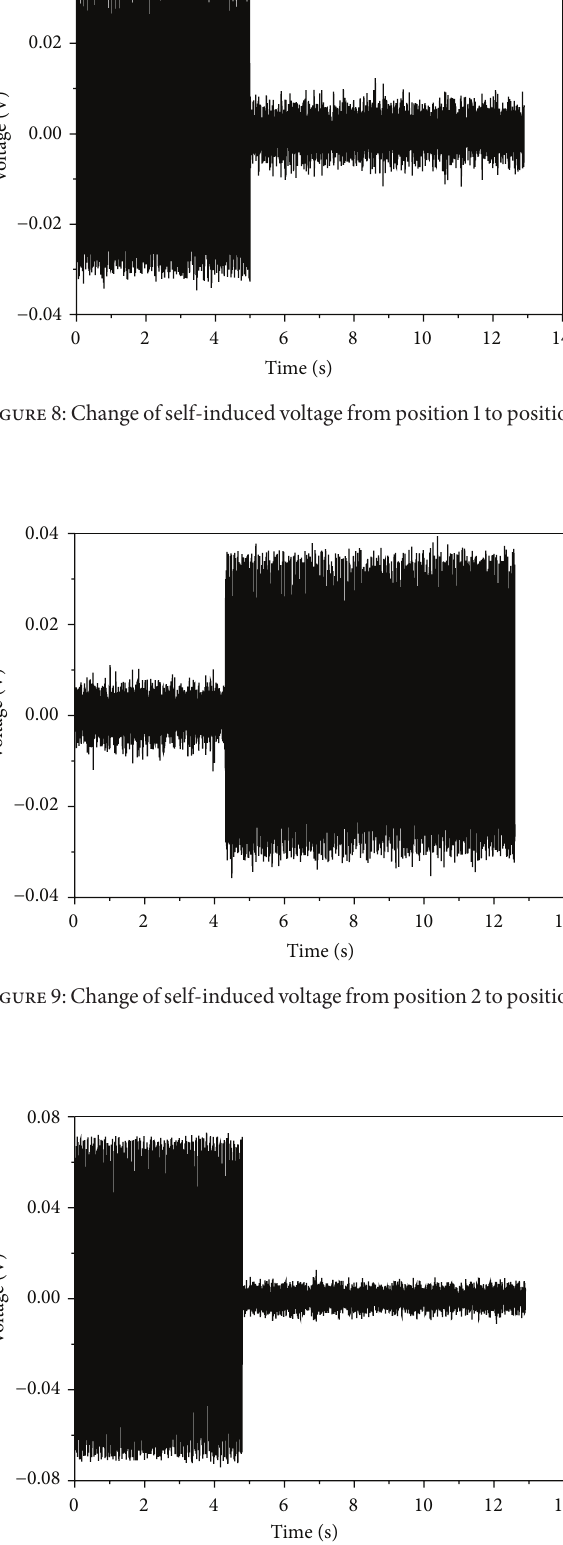
Figure 10: Change of self-induced voltage from position 1 to posi- tion 2.